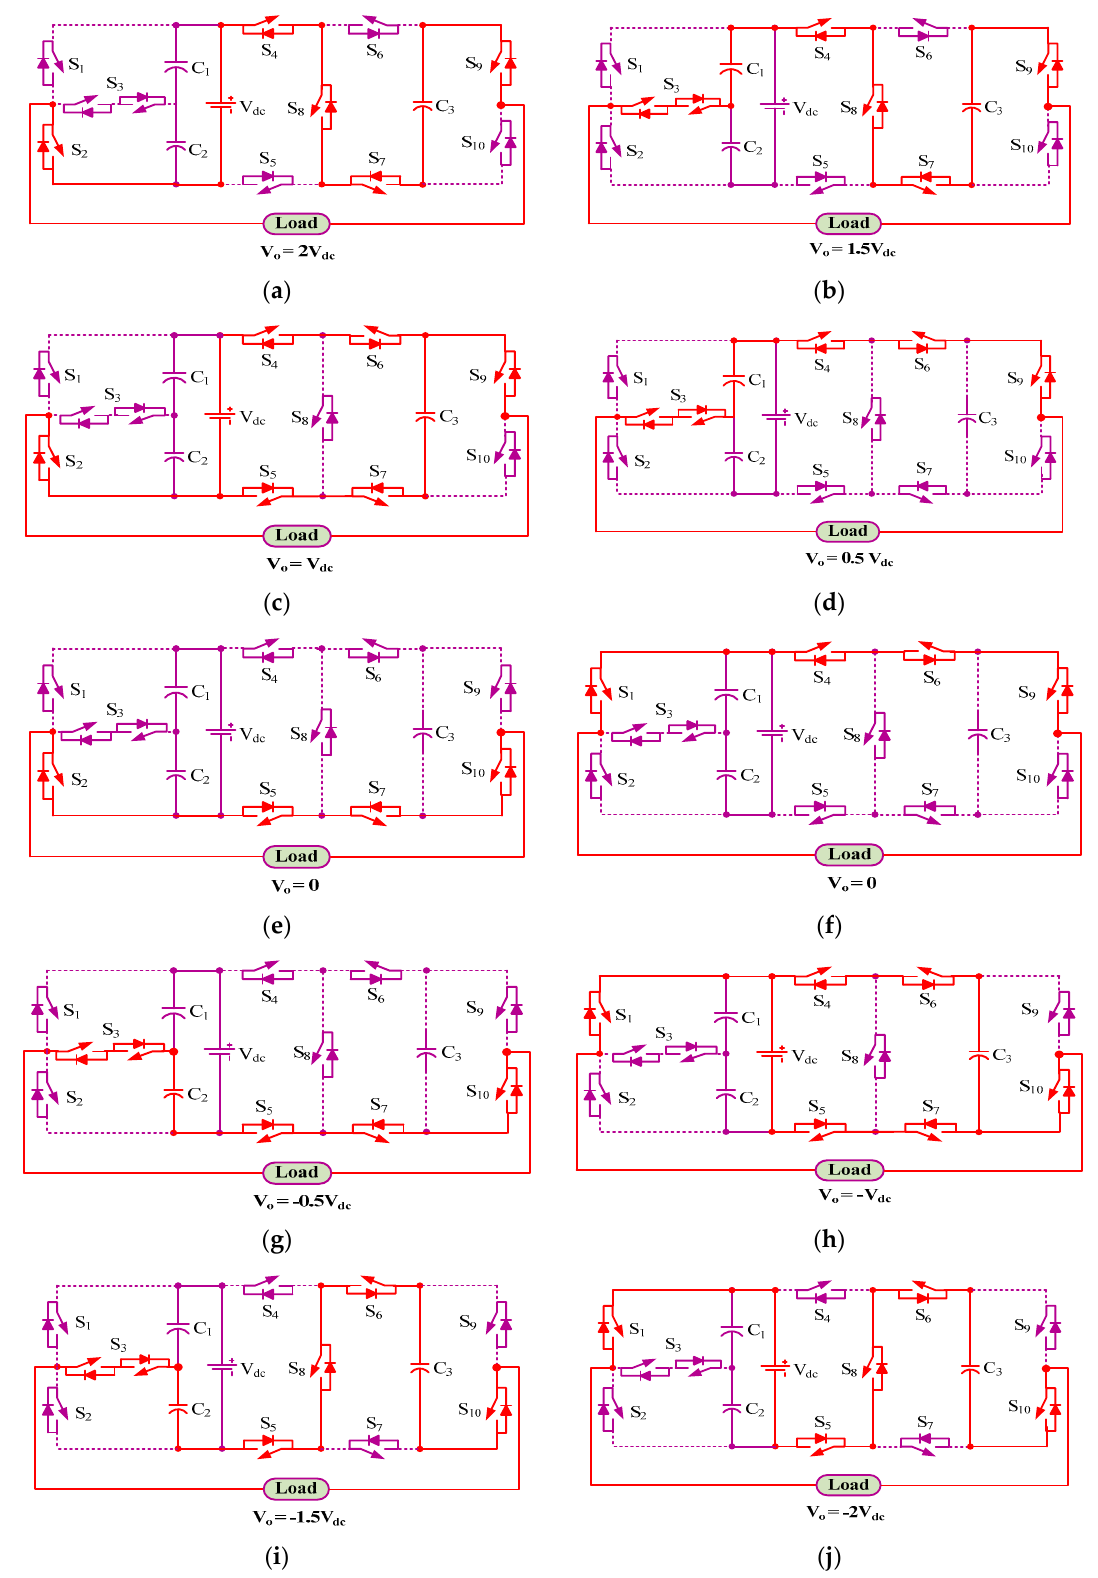
Figure 3. Operational diagrams of nine-level SCMLI representing different possible output voltage levels: ( a ) V o = 2V dc , ( b ) V o = 1.5V dc , ( c ) V o = V dc , ( d ) V o = 0.5V dc , ( e ) V o = 0, ( f ) V o = 0, ( g ) V o = − 0.5V dc , ( h ) V o = − V dc , ( i ) V o = − 1.5V dc , and ( j ) V o = − 2V dc.